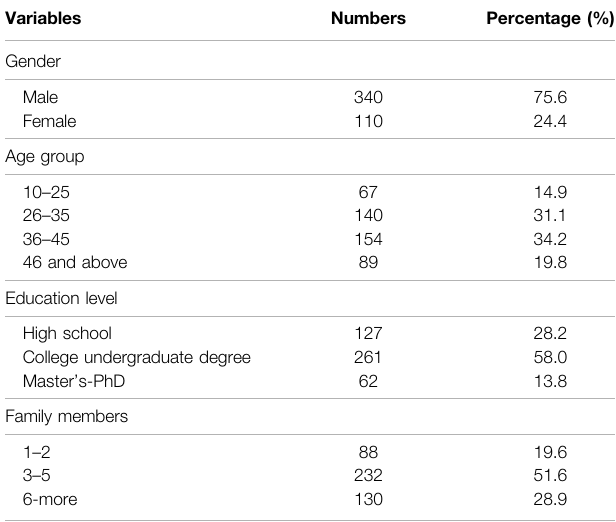
TABLE 1 | Attributes of the sample